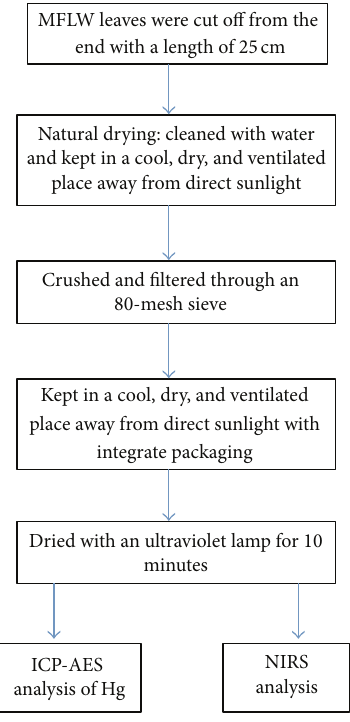
Figure 1: The preparation of MFLW